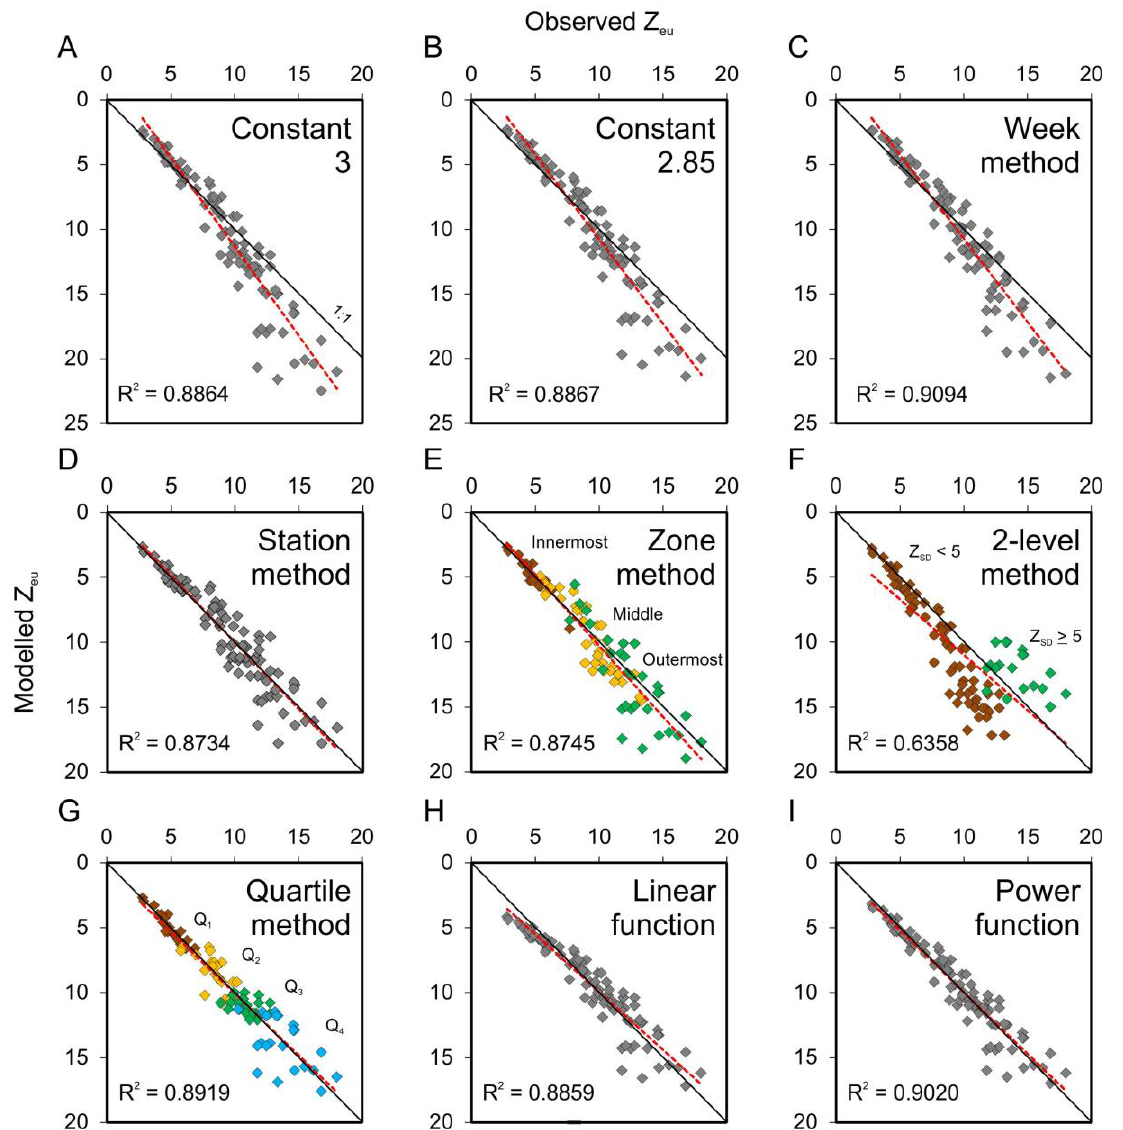
Figure 3. The observed Z values plotted against the predicted values that are modeled by eu the nine methods tested in this study: (A) by constant 3; (B) average constant 2.85; (C) week method; (D) station method; (E) zone method; (F) 2-level method; (G) quartile method; (H) linear function; and (I) power function. The black 1:1 lines indicate perfect correlations, and the red dashed lines are trendlines related to the coefficients of determination shown on the corners. For each case, n =